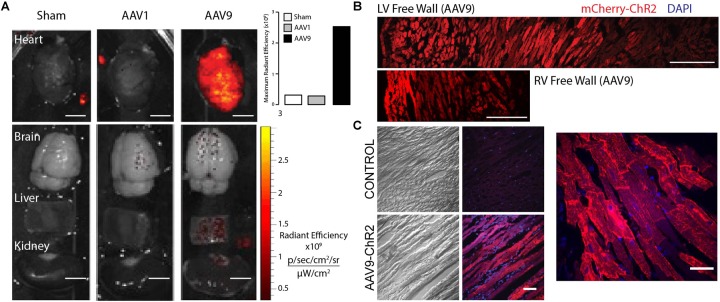
In vivo AAV9-mediated mCherry expression in the adult rat heart provides robust, predominantly cardiomyocyte-specific transgene delivery. (A) Systemic delivery of 0.5 × 1012 viral particles resulted in robust cardiac-specific expression of mCherry in 4 weeks using AAV9, but not AAV1 as measured using radiant efficiency. Other major organs (including brain, liver, and kidney) showed little to no signs of AAV-mediated infection. Scale bars are 500 μm. (B) AAV9-mediated transgene delivery resulted in transmural ChR2-mCherry expression in both the LV and RV free walls. Scale bars are 250 μm. (C) High-resolution images (brightfield and fluorescence) show cardiomyocyte-specific ChR2-mCherry expression using AAV9-mediated delivery. Scale bars are 50 μm.